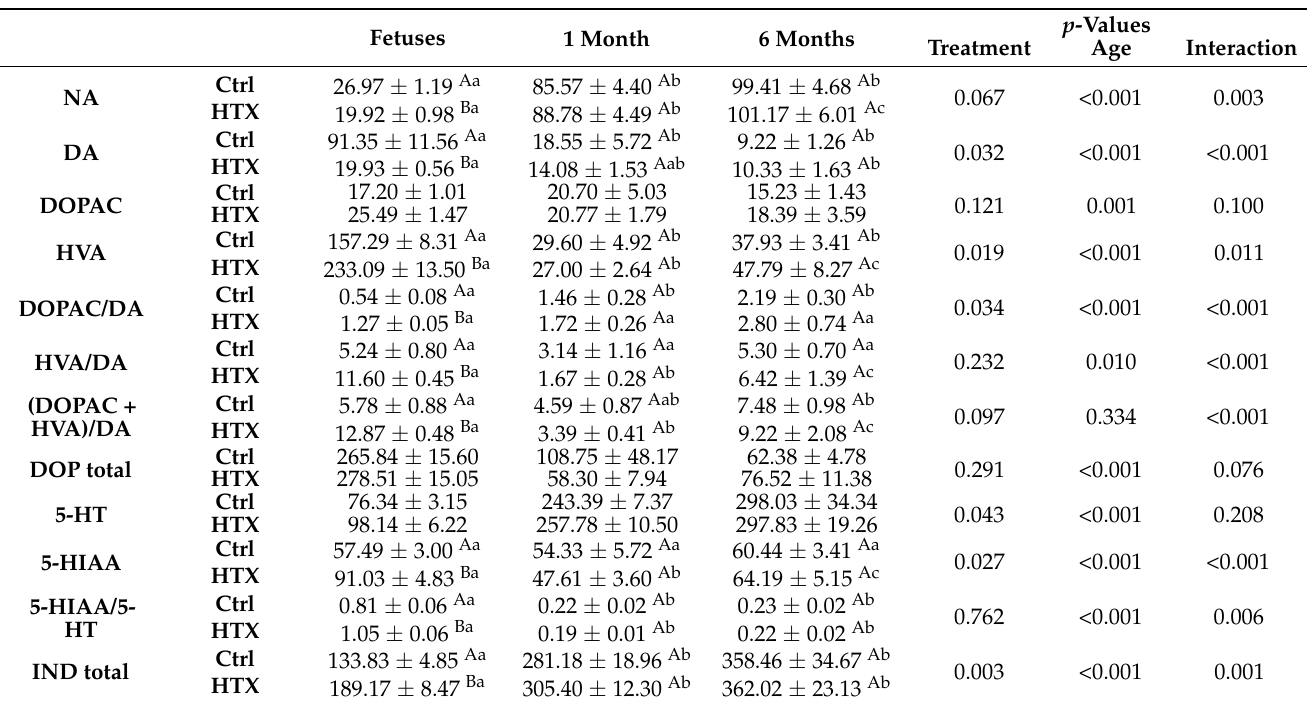
Table 3. Effects of the supplementation of the maternal diet without (Ctrl) or with HTX on the mean values of the concentration of neurotransmitters in the prefrontal cortex of 100-day-old fetuses and 1-month- and 6-month-old pigs.